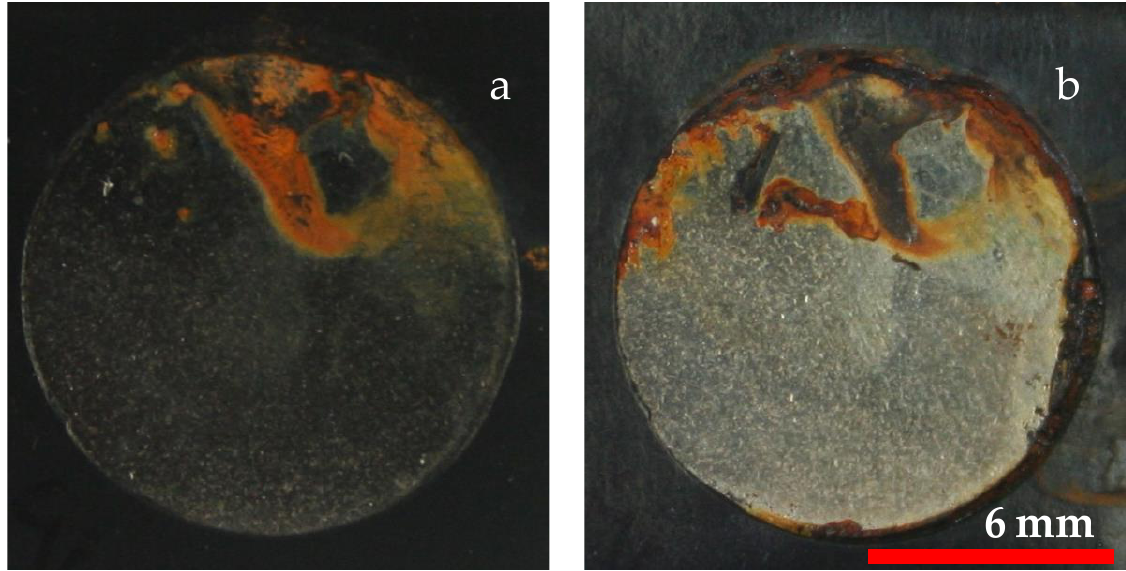
Figure 13. Heat-treated deposit images after 4 h ( a ) and 10 days ( b ) of salt spray test.